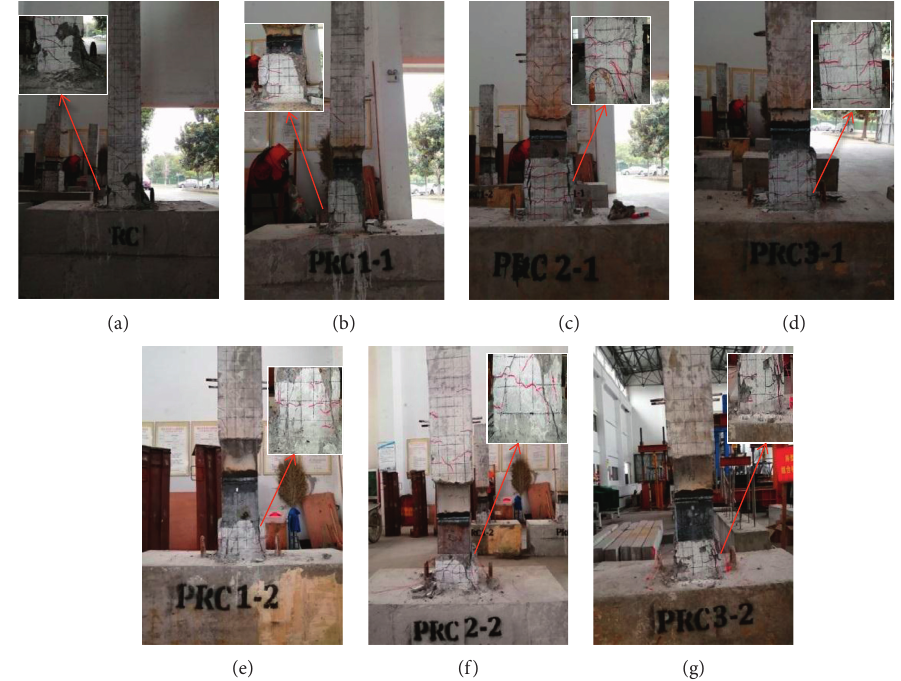
Figure 6: Failure mode of specimens: (a) specimen RC, (b) specimen PRC1-1, (c) specimen PRC2-1, (d) specimen PRC3-1, (e) specimen PRC1-2, (f) specimen PRC2-2, and (g) specimen